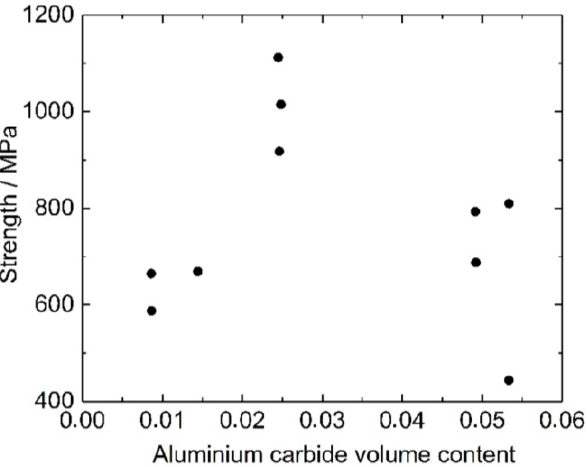
Figure 4. Dependence of the bending strength of the carbon-fibre/aluminium-matrix composite on the content of the carbide phase at the interface. The fibre volume fraction is 46%. The experimental data are from Portnoi et al. [21].